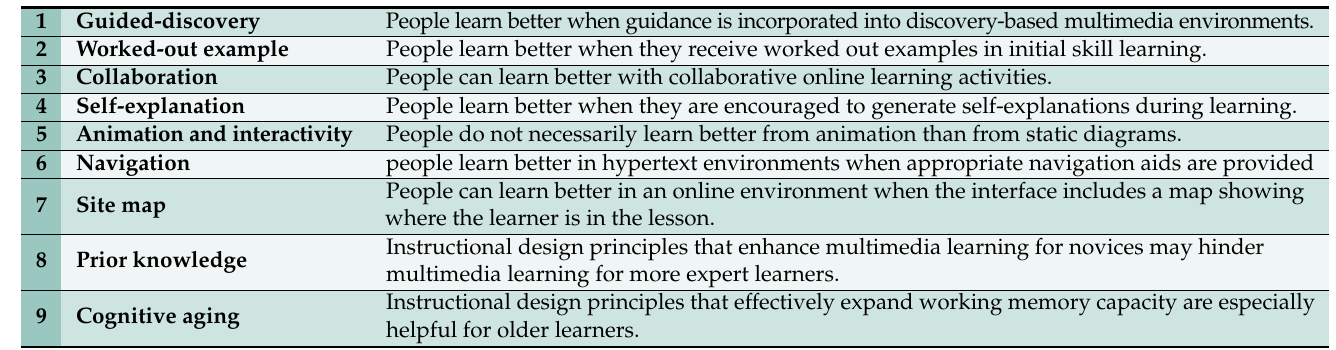
Table 3. Advanced principles of Multimedia